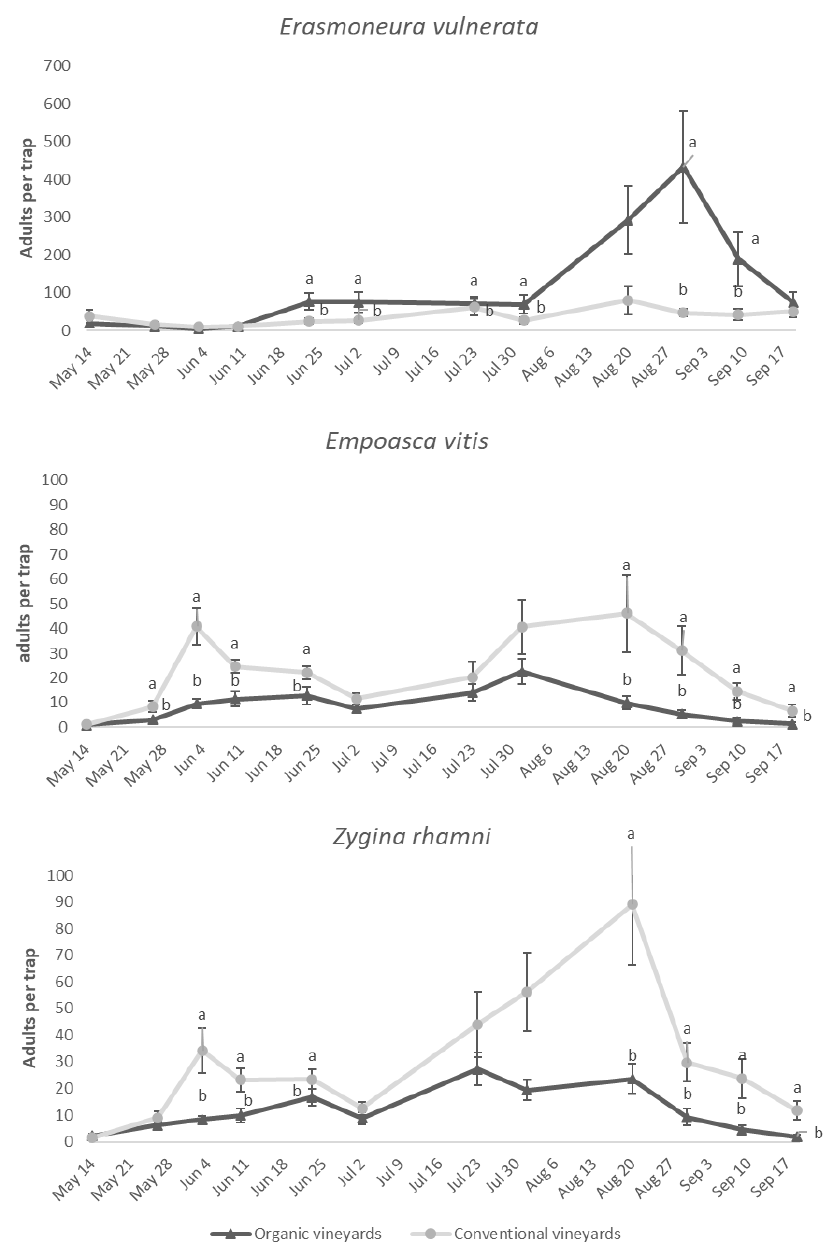
Figure 11. Mean (± std. err.) number of adult E. vulnerata , Z. rhamni and E. vitis catches on traps placed in organic and conventional vineyards. Different letters indicate significant differences based on Tukey’s test on least square means (α = 0.05) of the number of adults caught on each date. Erasmoneura vulnerata nymph densities were higher in organic vineyards than in conventional vineyards (F = 4.61; d.f. = 1; 18; p = 0.046; Figure 12). The effect of time was also significant (F = 3.72; d.f. = 10, 95.1; p < 0.001; Figure 11) in contrast to that of the interaction vineyard management * time (F = 1.43; d.f. = 10, 95.1; p = 0.18). Vineyard management did not affect E. vitis or Z. rhamni nymphs (F = 0.66; d.f. = 1, 2.87; p = 0.478; F = 1.8; d.f. = 1, 12.7; p = 0.203; for E. vitis and Z. rhamni , respectively, Figure 11). The effect of time and the interaction vineyard management * time were not significant for